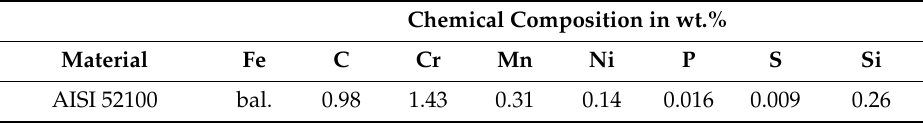
Figure 3. Initial microstructure (before heat treatment) of the macroscopic samples (single-impact peening); etched 25–40 s in 3% alcoholic HNO 3. Table 2. Chemical composition of the plates for singe-impact